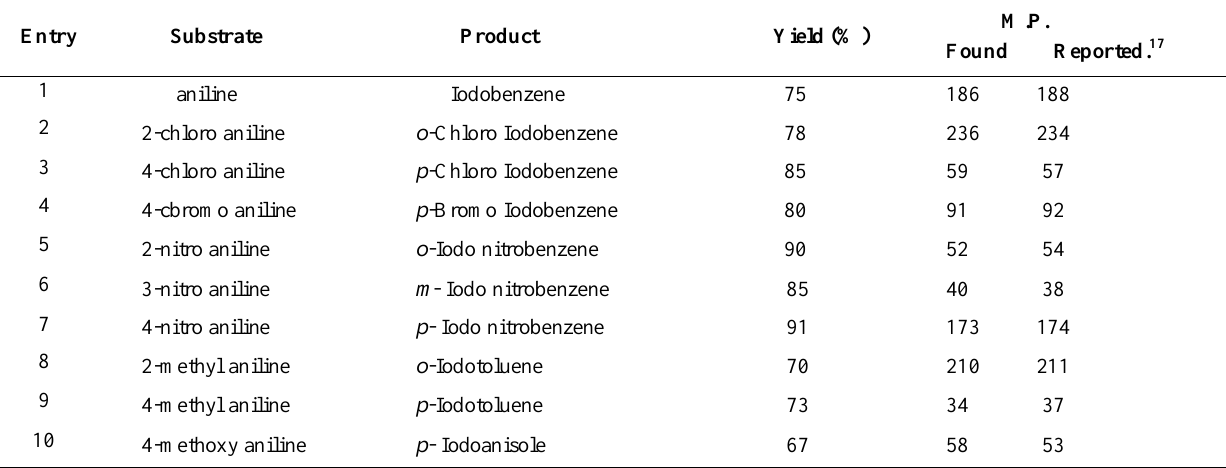
Table. 2 . Conversion of various aromatic amines to the corresponding aryl iodides under solvent-free conditions at room temperature